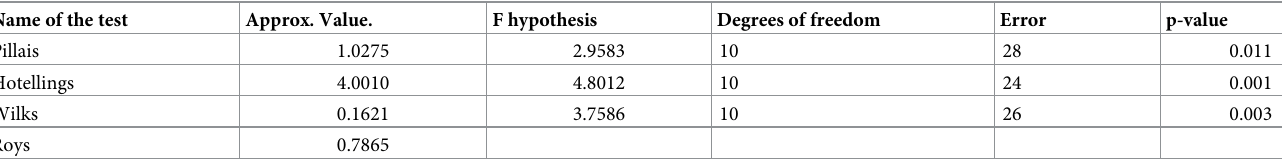
Table 5. Significance multivariate test.